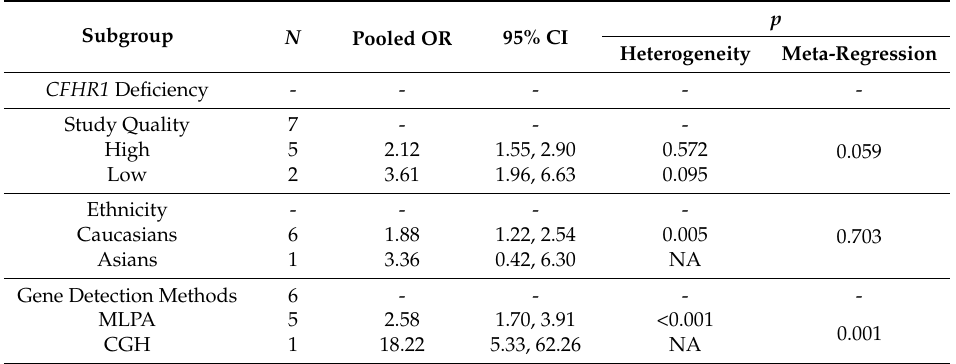
Figure 2. Forest plot on the association between CFHR1 deficiency and aHUS risk. For each study, the estimation of OR and its 95% confidence interval (95% CI) are plotted with a box and a horizontal line. The pooled odds ratio is represented by a diamond. The area of the black squares reflects the weight of the study in the meta-analysis. Table 2. Meta-analysis of the association between the CFHR1 deficiency/ CFHR1/R3 deficiency and atypical hemolytic uremic syndrome risk.